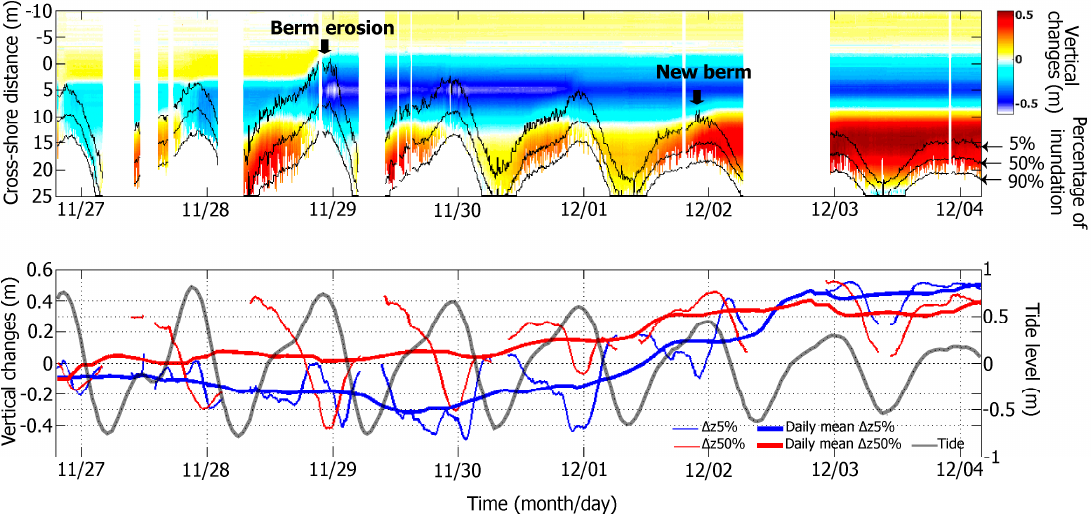
Figure 9. Beach response measured using the Lidar, with the top panel showing the cumulative vertical changes overlain by the 5%, 50% and 90% of swash inundation lines (percentage that specific swash location is covered by water during a 10 min segments); red colors indicate accretion while blue colors indicate erosion. The bottom panel presents the cumulative vertical bed elevation changes observed on the 5% and 50% inundation lines ( Δ z 5% and Δ z50% respectively), together with the daily-mean values. The tidal elevation is indicated in grey.